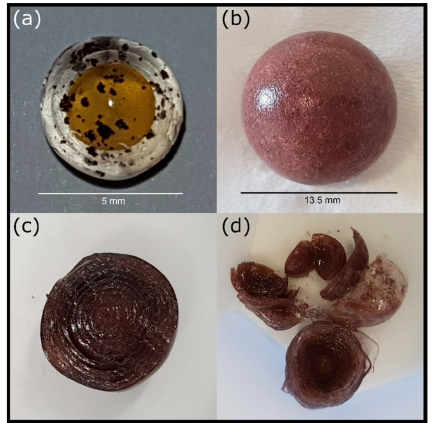
Figure A1. Multicompartment beads with PLE located inside the chitosan core and Grubbs’ catalyst located in the octyl-grafted alginate amide shell: ( a ) three shell layers of alginate amide with Grubbs’ catalyst non-crushed, ( b ) twelve shell layers of alginate amide with crushed Grubbs’ catalyst for particle size reduction, ( c ) cross-section of twelve-layer-bead, ( d ) detached layers from the cut twelve-layer